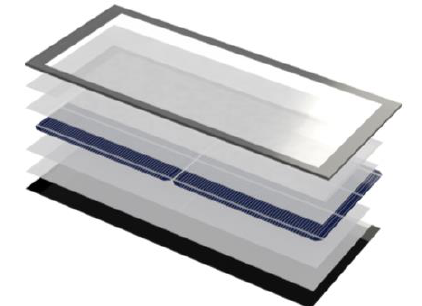
Fig. 5. Micromodule 2 cells 130·138 mm proposed by Electrotile Company.